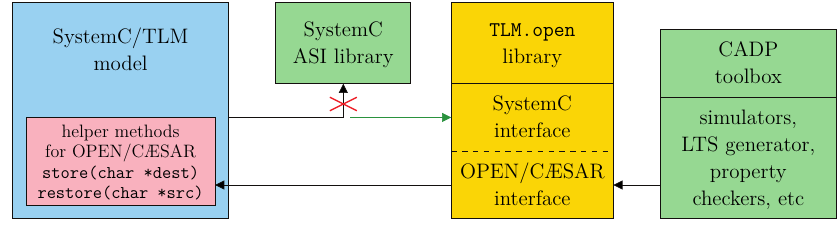
Figure 3 Overview of the verification framework. The model is linked with the SystemC TLM.open library instead of the ASI